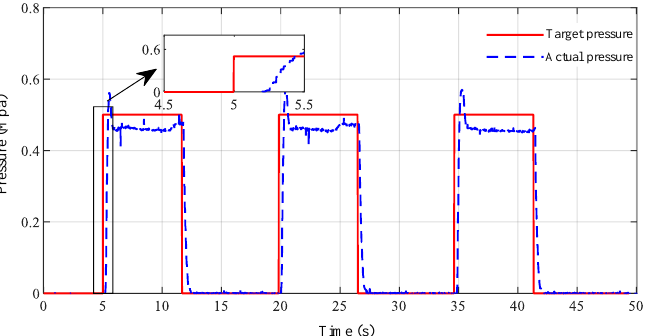
Figure 13. Air pressure response curve of 0.5 MPa target pressure during braking.